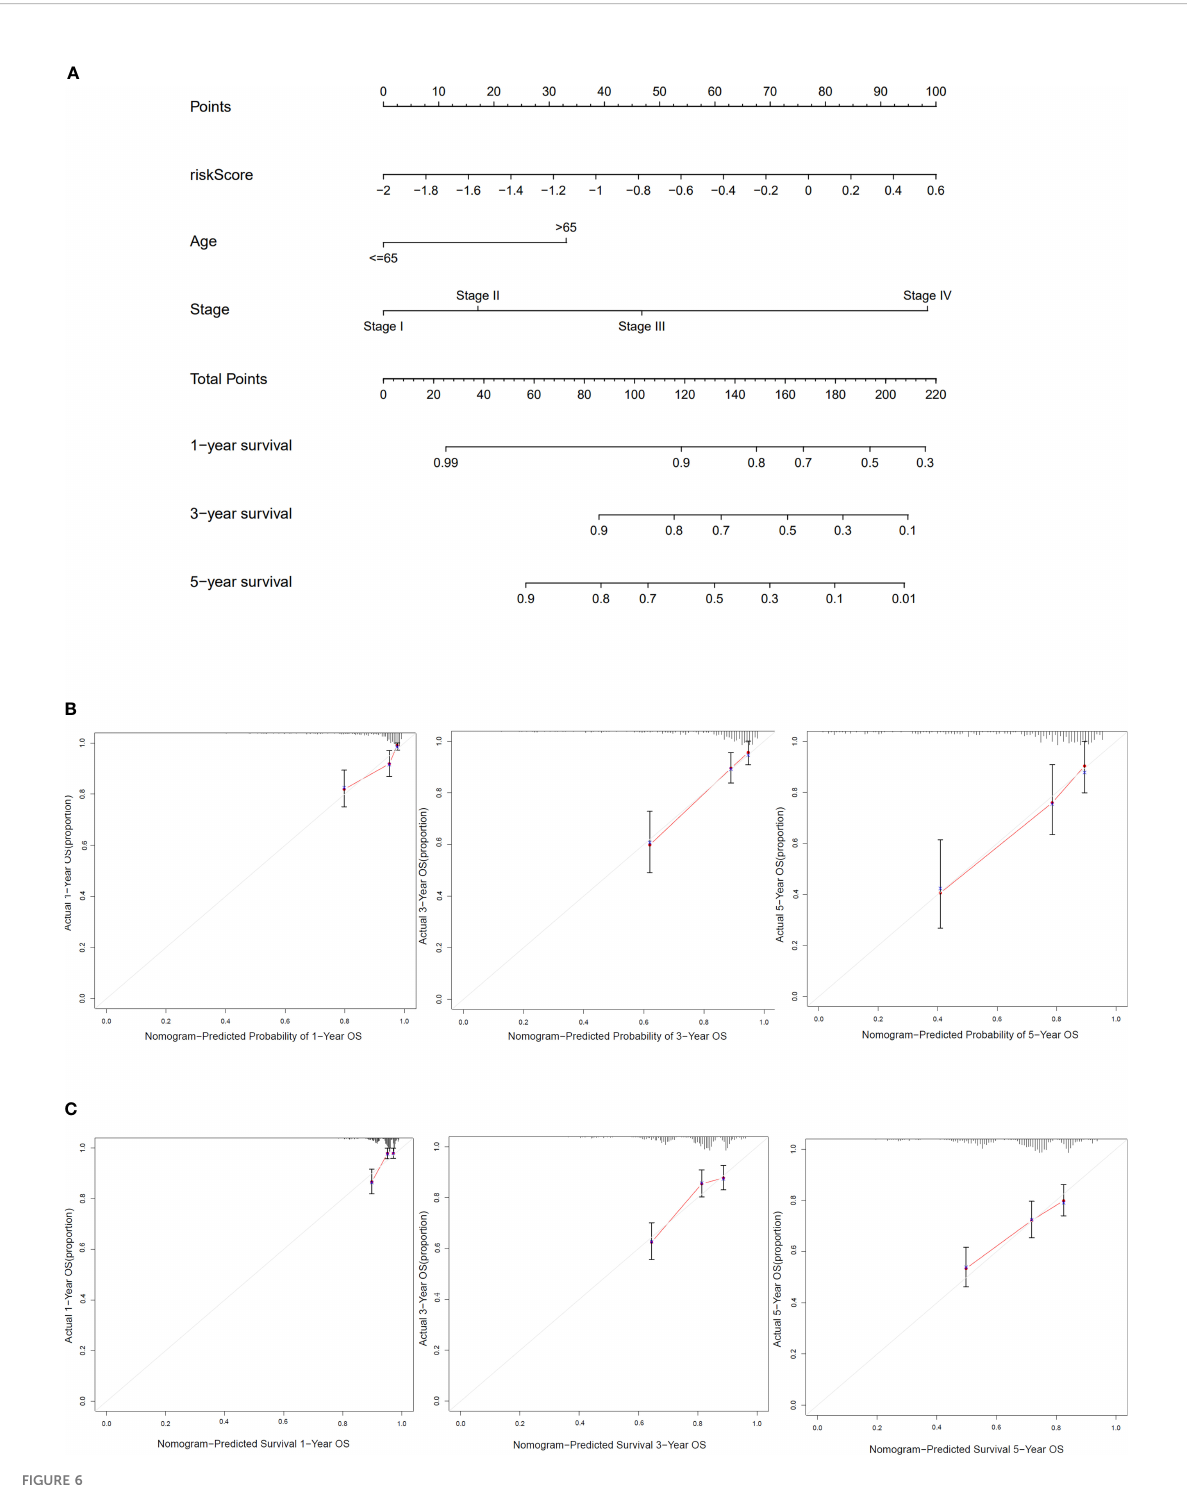
FIGURE 6 Construction and veri fi cation of the nomogram. (A) The nomogram based on risk score, age, and stage to predict the 1-, 3-, and 5-year survival in COAD patients. (B) Calibration curves for 1, 3, and 5 years of TCGA dataset. (C) Calibration curves for 1, 3, and 5 years of GEO